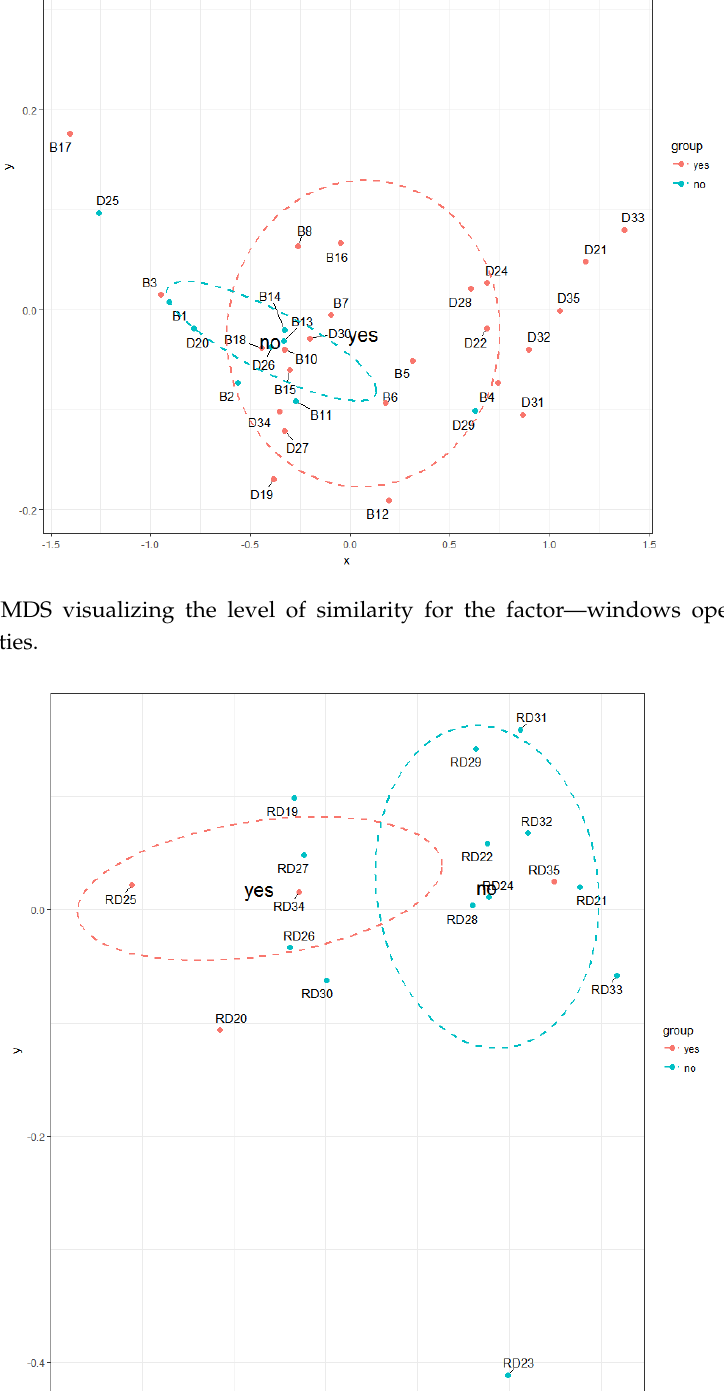
Figure 17. NMDS visualizing the level of similarity for the factor—attached garage.